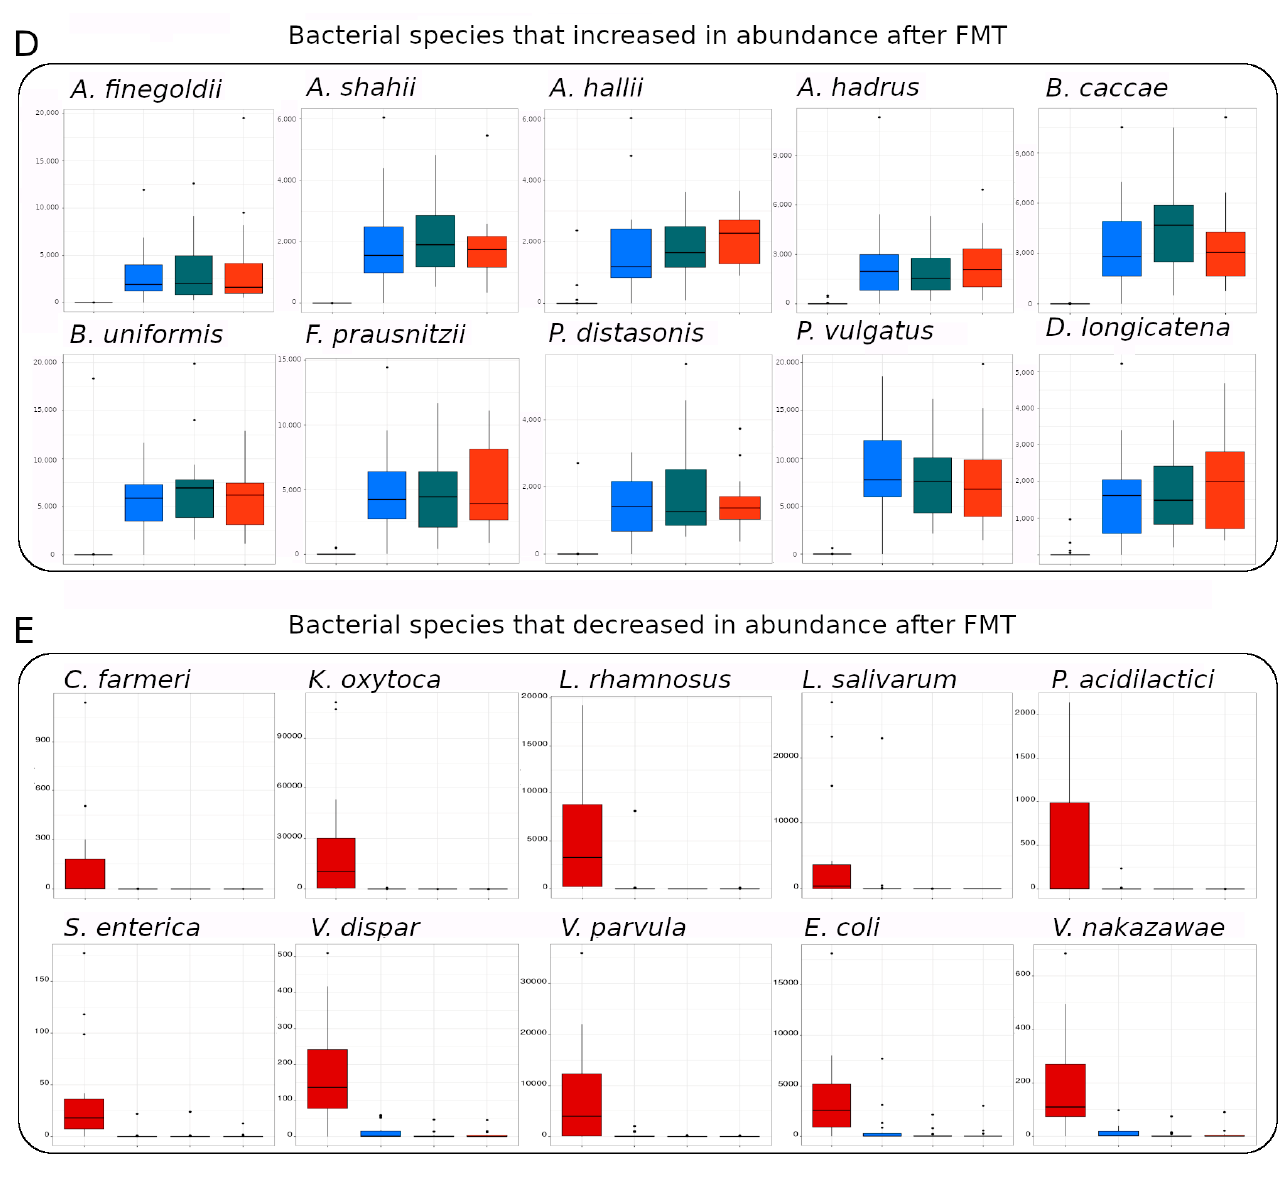
Figure 1. Fecal microbial transplantation (FMT) increases microbiome alpha diversity, increases the abundance of homeostatic bacteria, and decreases the abundance of opportunistic potentially pathogenic bacteria. ( A ) Hierarchical clustering on Bray–Curtis distances between all pairs of samples included in this study. ( B ) Principal coordinate analysis on Bray–Curtis distances between all pairs of samples included in this study. ( C ) Shannon diversity indices for each sample. In ( A – C ), 0 WPF, 1 WPF, 4 WPF, and 12 WPF refers to weeks post-FML. Hollow circles represent the Shannon index of individuals, while solid dots represent additional marks for observations considered